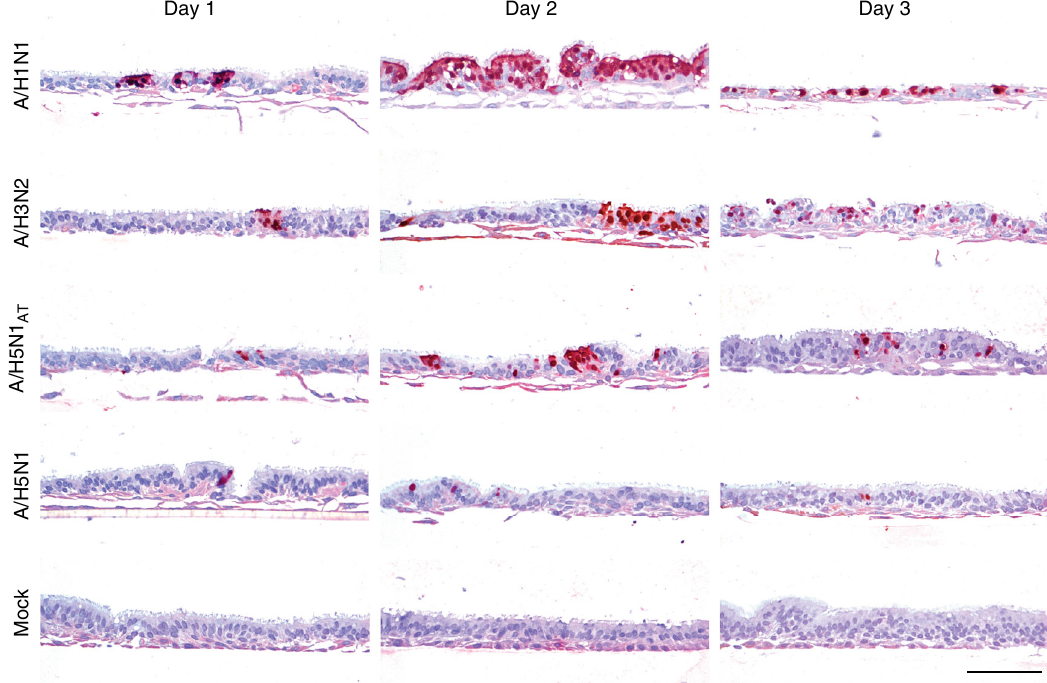
Fig. 4 Airborne transmissible in fl uenza A viruses infected the human respiratory epithelium. Representative pictures of primary cultures of human nasal respiratory epithelium (Mucilair TM ) inoculated with A/H1N1, A/H3N2, A/H5N1 AT , A/H5N1 viruses or PBS (Mock). In fl uenza A virus nucleoprotein expression was determined by immunohistochemistry (IHC) and is shown as a red stain. Scale bar 100 μ